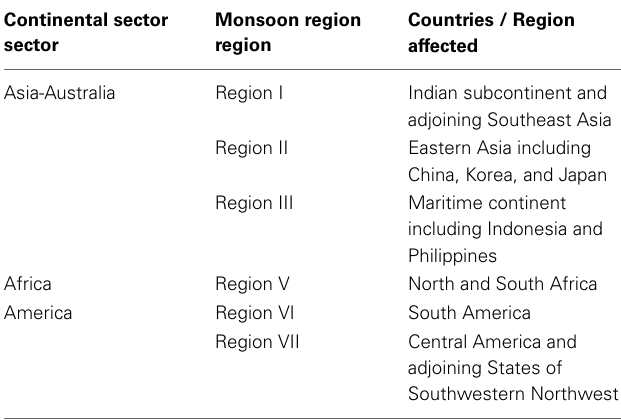
Table 2 | Monsoon regions three main continental sectors (Saha,